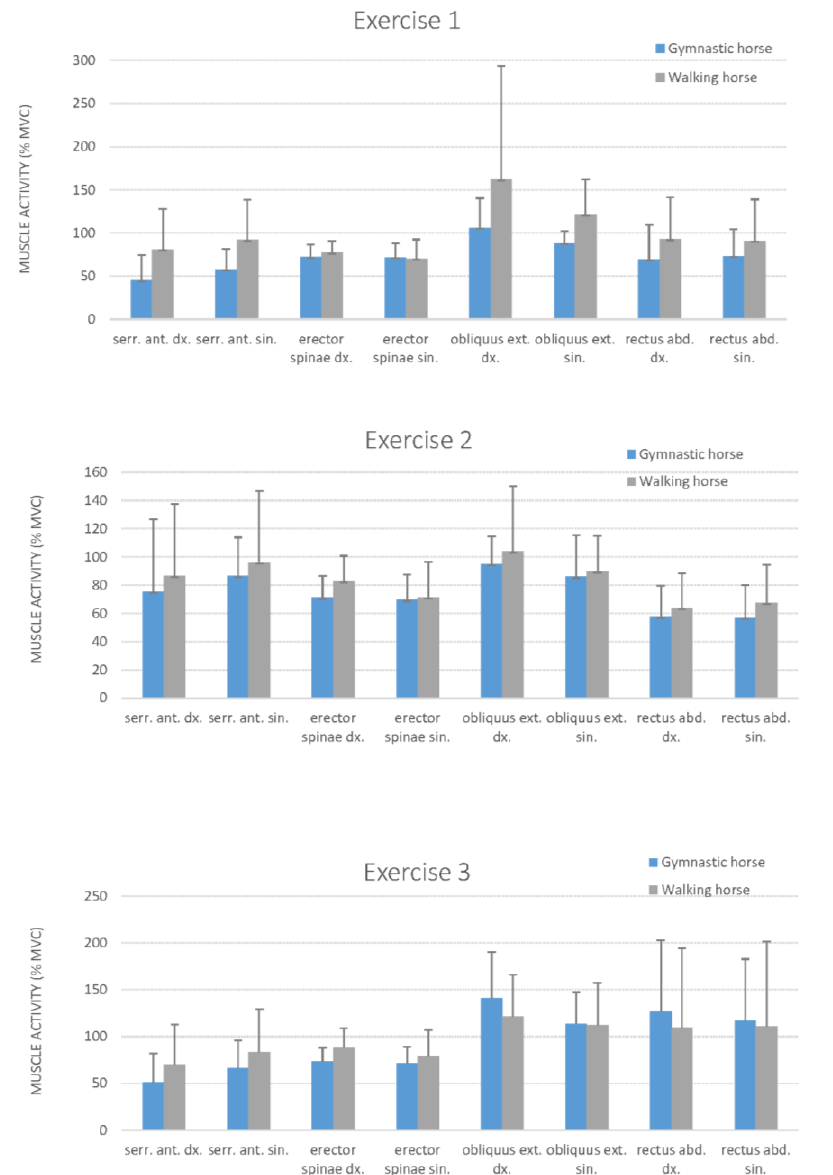
Figure 2. The activity of tested muscles (% MVC) during the three exercises performed by probands on gymnastic vs. walking (in step) horse: Exercise 1, the elevation of the knees; Exercise 2, rotation of the trunk; Exercise 3, clapping the lower limbs. The values are averages of all probands (n = 9). See Methods for full muscle names.